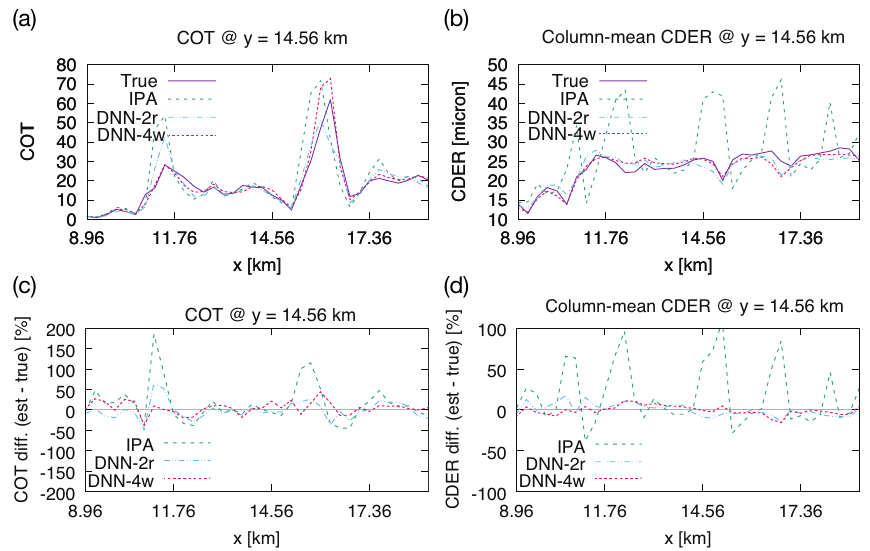
Figure 6. Examples of horizontal distribution of estimated (a) COT and (b) CDER by the IPA retrieval and DNNs for a view zenith angle of 0 ◦ at y = 14.56km in Fig. 5 and the relative error of the estimated (c) COT and (d) CDER. The sun is located on the left-hand side with an SZA of 60 ◦ .